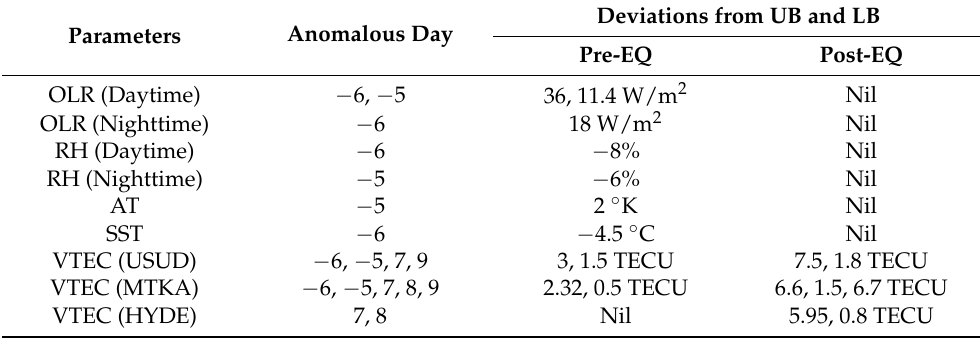
Table 1. The anomalies detected using statistical